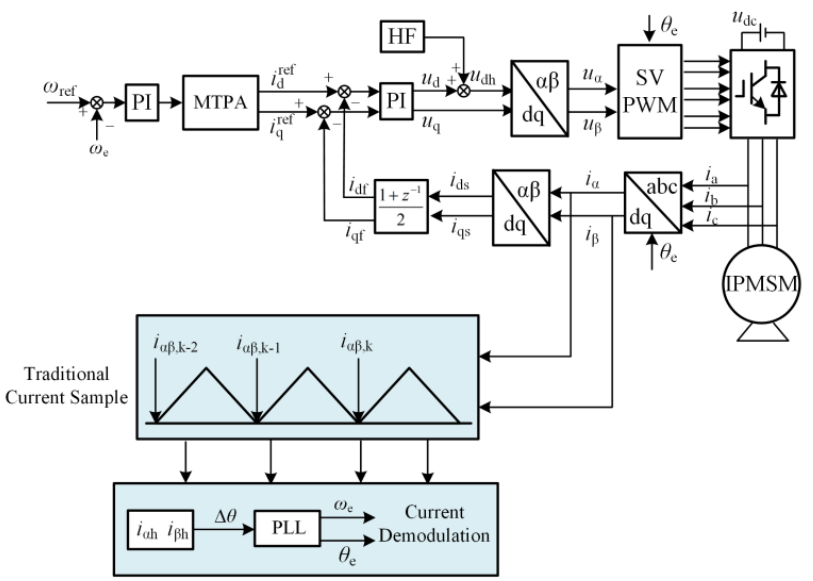
Figure 1 is the traditional sensorless control block diagram based on the high-frequency square wave signal injection method.